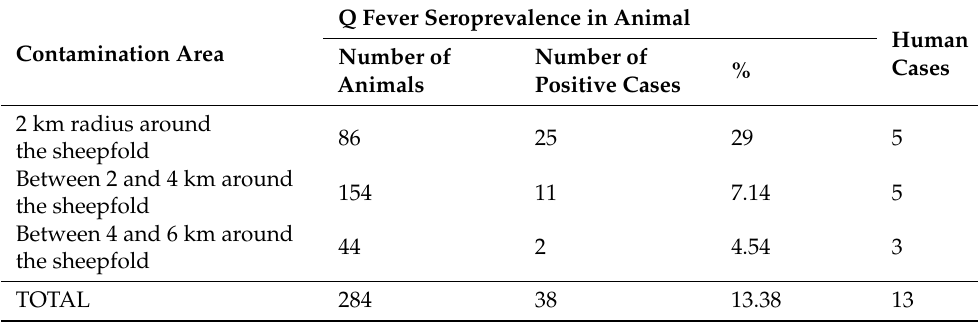
Table 5. Seroprevalence in animals and human cases of Q fever around the sheepfold according to 2 km perimeters.